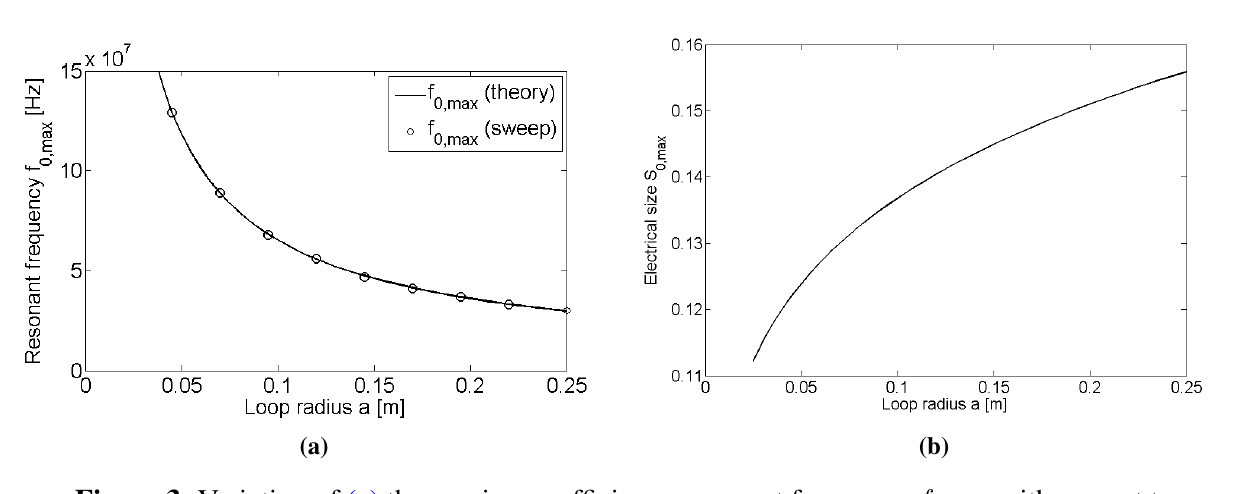
with respect to 0 ,max when operating 0 ,max